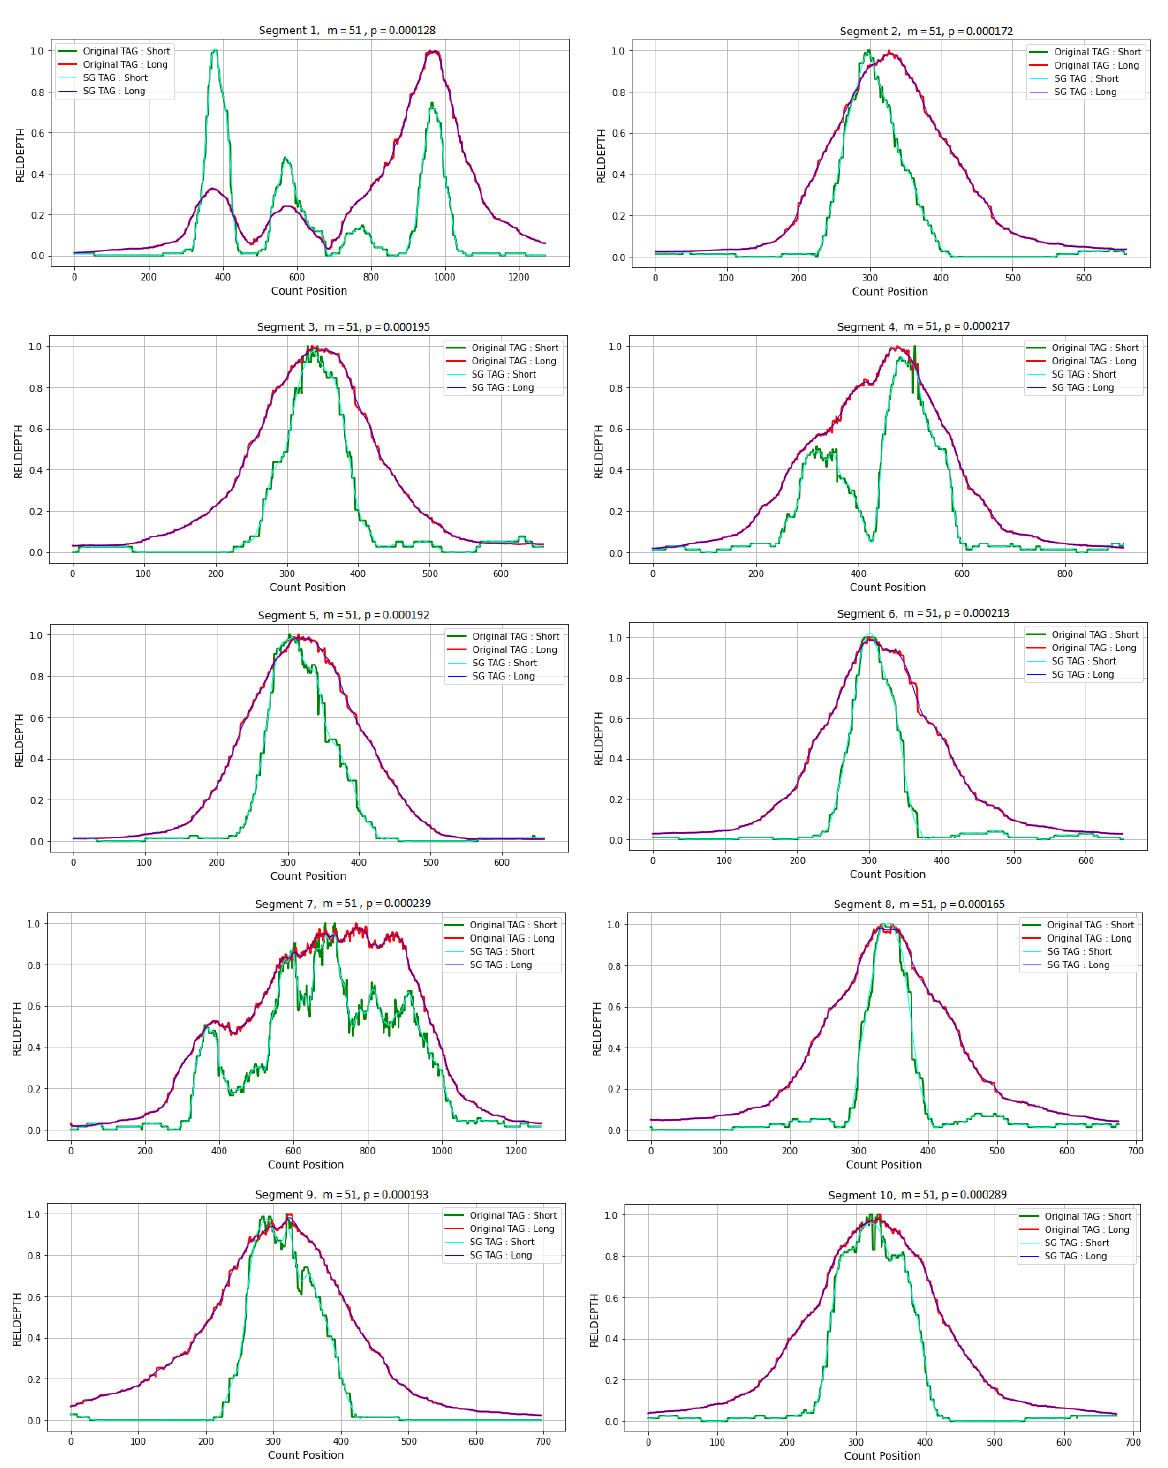
Figure 6. Show CNV peaks from different genomic segment filtered using Adaptive Savitzky–Golay filters. Green and red solid lines are the original short- and long-tag CNV peaks , respectively; cyan and blue solid lines are the smoothed the short- and long-tag CNV peaks,